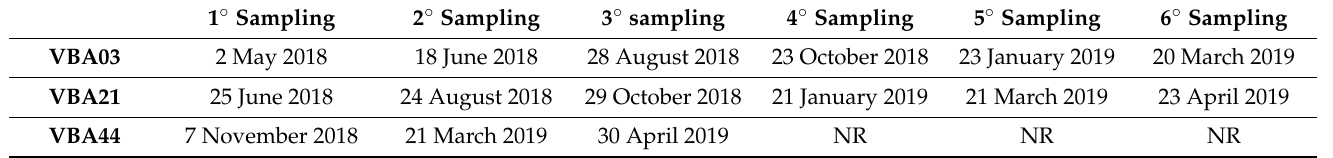
Table 2. Identification of sampling date (day, month, and year) during subsequent recaptures of ring-tailed coatis ( Nasua nasua ) positive to Ehrlichia sp. sampled and recaptured in two areas, namely Parque Estadual do Prosa and Vila da Base A é rea, city of Campo Grande, State of Mato Grosso do Sul, Midwestern Brazil. All dates when positive PCR results were found are bolded.